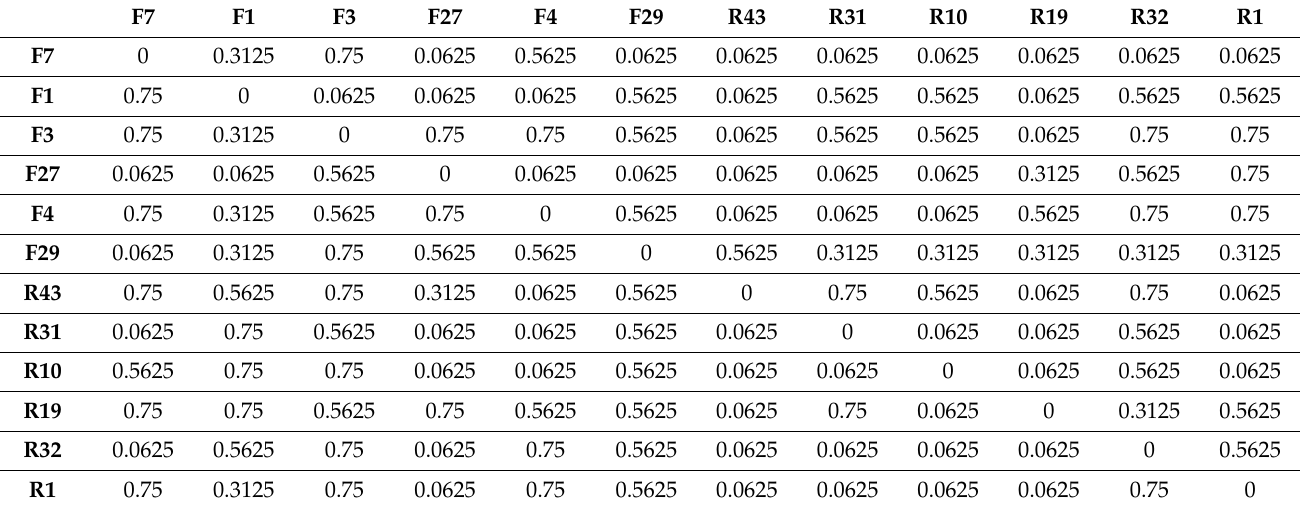
Table 5. Adjacency matrix.